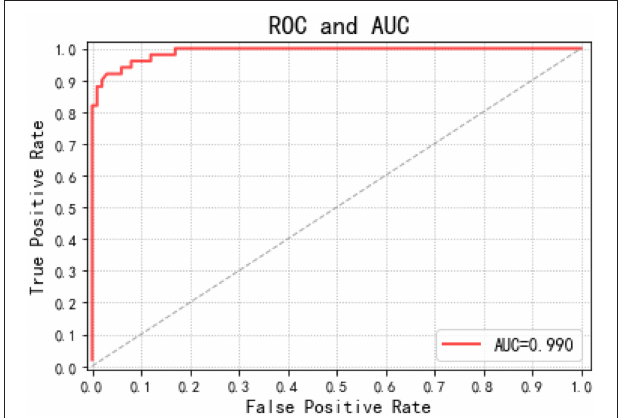
FIGURE 7 | ROC curve and AUC